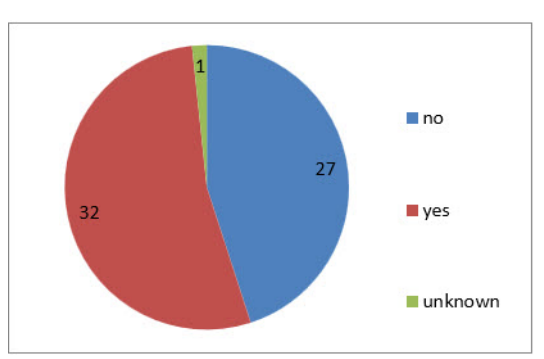
Figure 1. Number of the respondents motivated for attending online classes